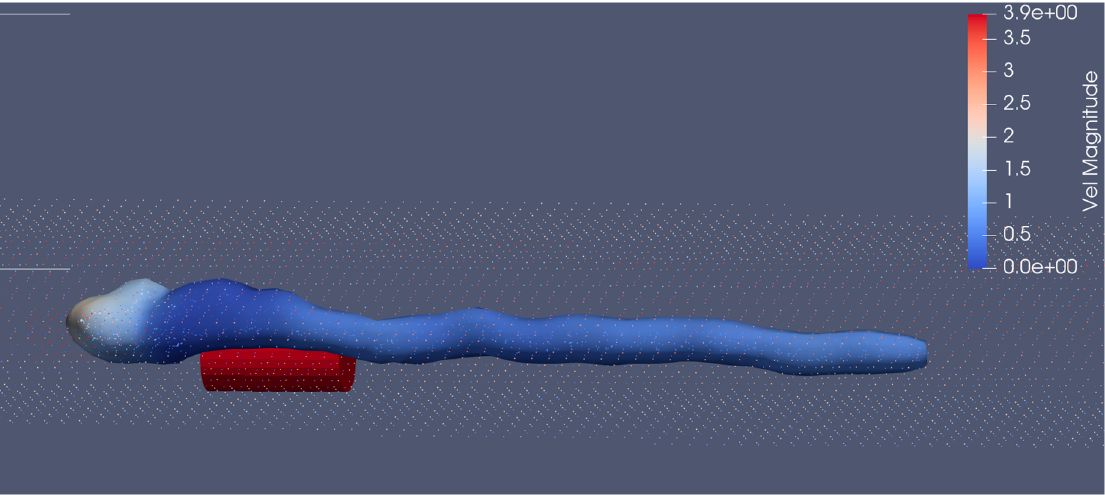
Figure 10. Image of the flow velocity profile over the solid in SPH.